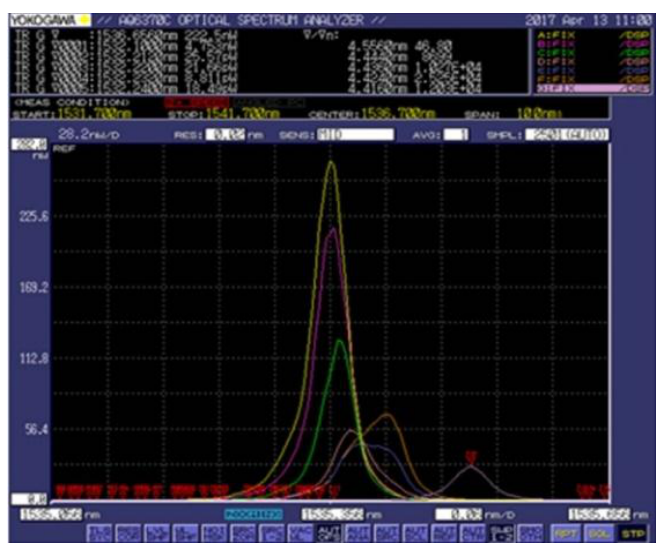
Fig. 7: OSA Graphics peaks shift of PCFI with respect humidity of the length 4 mm .